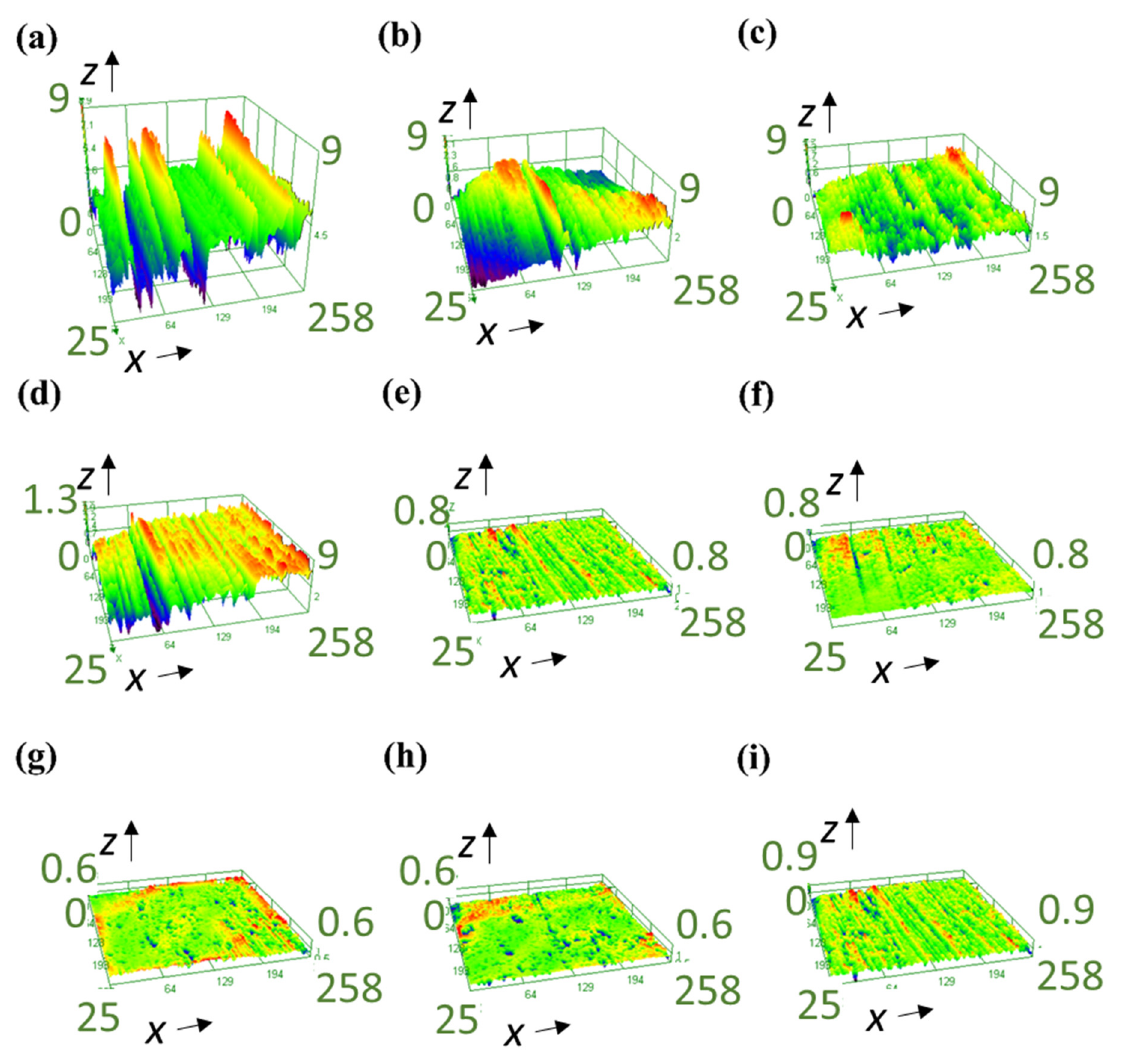
Figure 6. The 3D optical profilometer images of worn surface of the pin at 20 N for the ( a ) neat oil, ( b ) 0.05 vol.% nanolubricant, ( c ) 0.10 vol.% nanolubricant, ( d ) 0.15 vol.% nanolubricant, ( e ) 0.20 vol.% nanolubricant, ( f ) 0.25 vol.% nanolubricant, ( g ) 0.30 vol.% nanolubricant, ( h ) 0.35 vol.% nanolubricant, and ( i ) 0.40 vol.% nanolubricant.